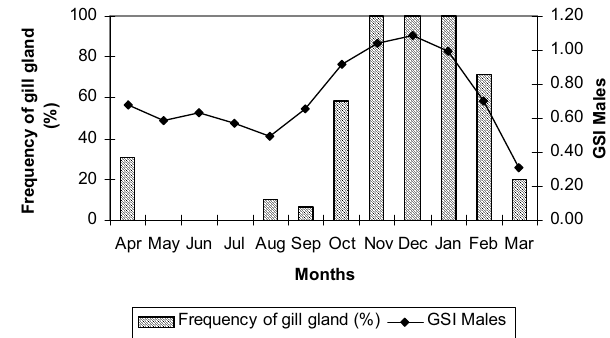
Fig. 4. Monthly variation of the GSI mean values and fre- quency of occurrence (%) of males of Aphyocharax anisitsi bearing gill glands, collected from April 2001 to March 2002 in the arroio do Salso, Rosário do Sul, RS, Brazil.